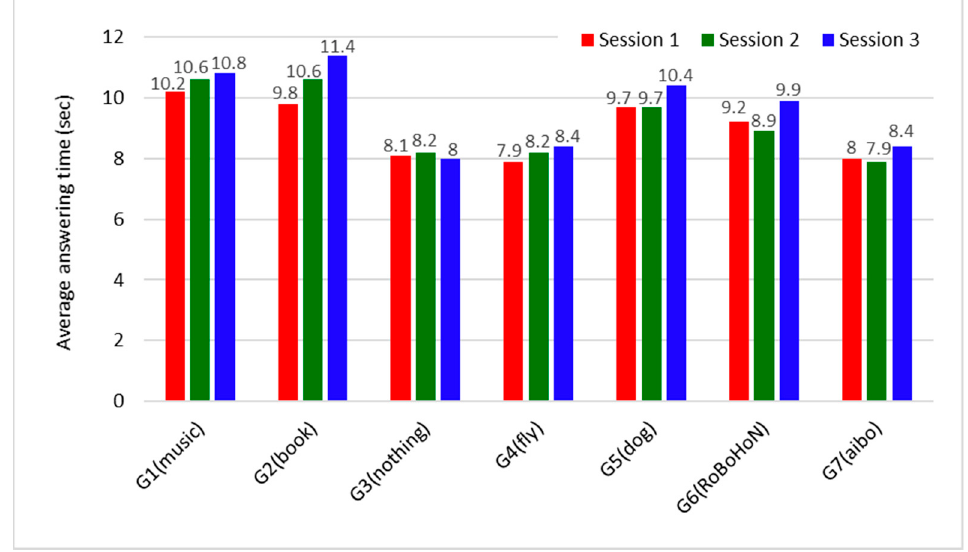
Figure 6. Average answering time for each session in groups.